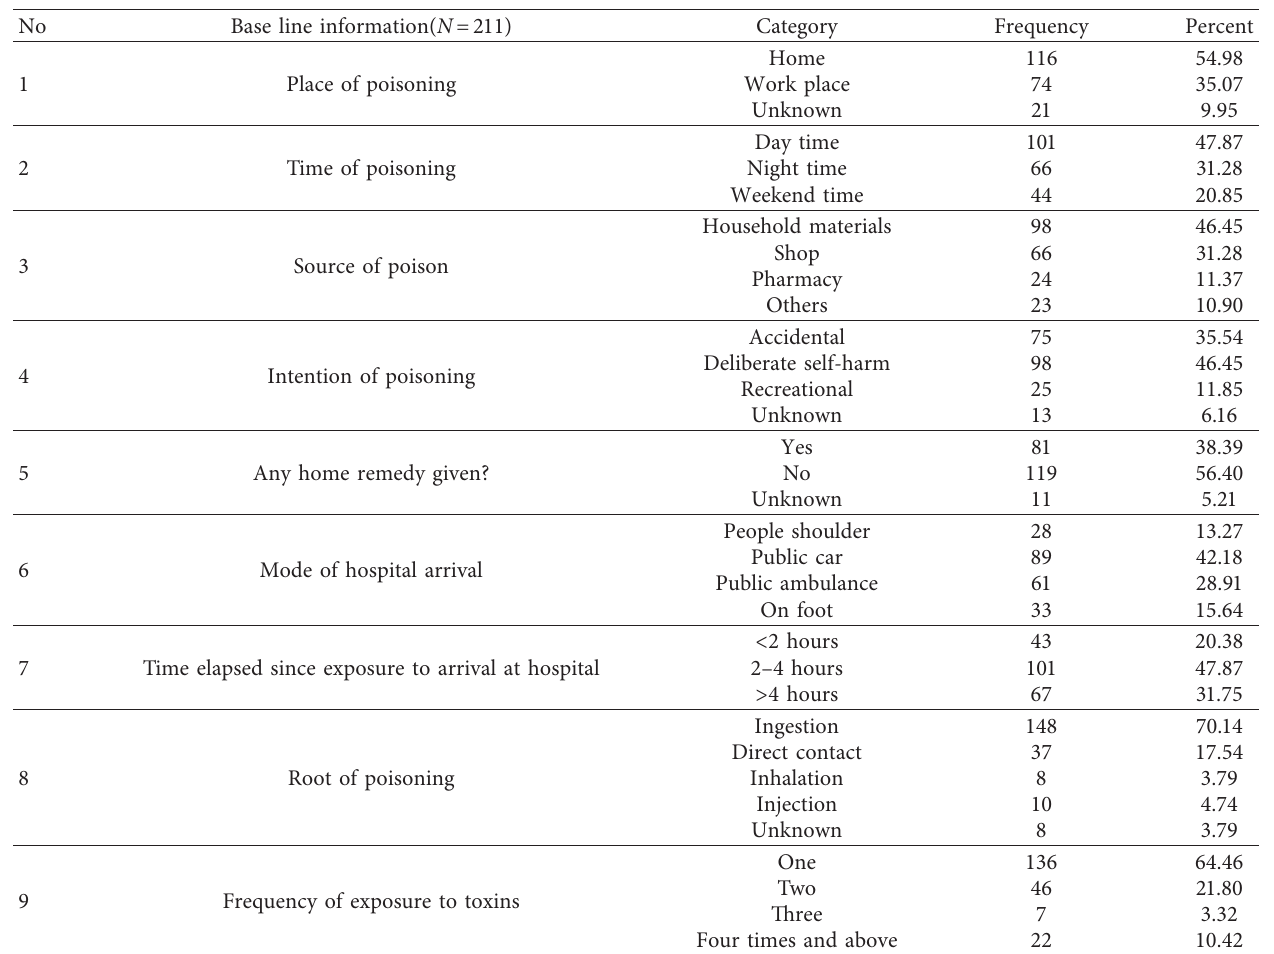
Table 5: Common contributing factors associated with poisoning among poisoned patients in western Ethiopia, 2018. No Base line information( N �